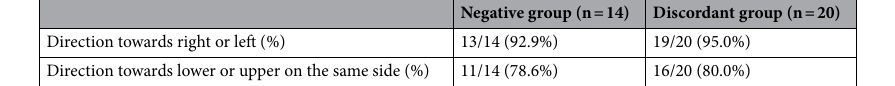
Table 2. Diagnostic success of parathyroid venous sampling